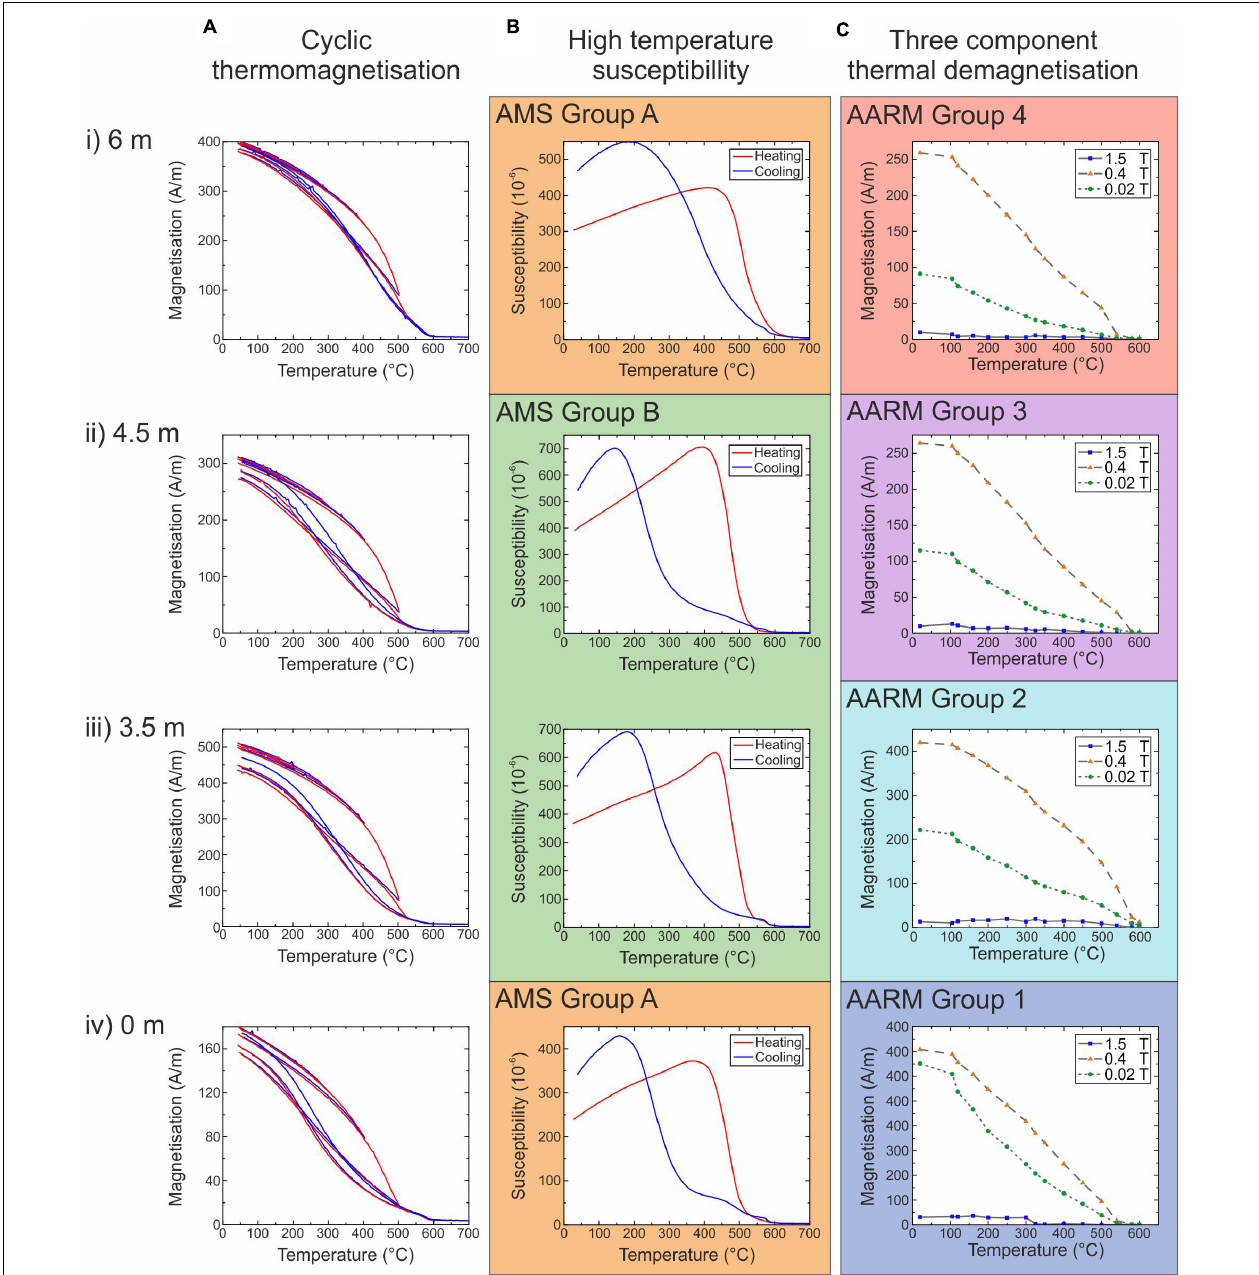
FIGURE 3 | Graphs showing data from (A) cyclic thermomagnetization, (B) high temperature susceptibility and (C) three component thermal demagnetization experiments for identification of magnetic carriers at select heights through the crinanite sill (see Table 2 ): (i) 6 m (the upper contact, sample 6.0b-G4), (ii) 4.5 m (sample 4.5a-G3), (iii) 3.5 m (sample 3.5a-G3), and (iv) 0 m (the lower contact, sample 0.0a-G1). In (A,B) the red curves are heating measurements and blue curves are cooling measurements. Background colors in (B,C) represent the two AMS and four AARM groups.